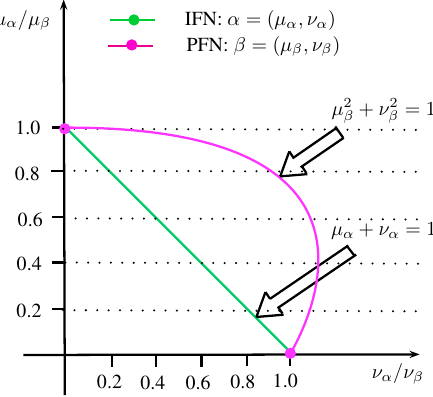
Figure 1. Comparison of spaces of the IFNs and the Pythagorean fuzzy numbers (PFNs).